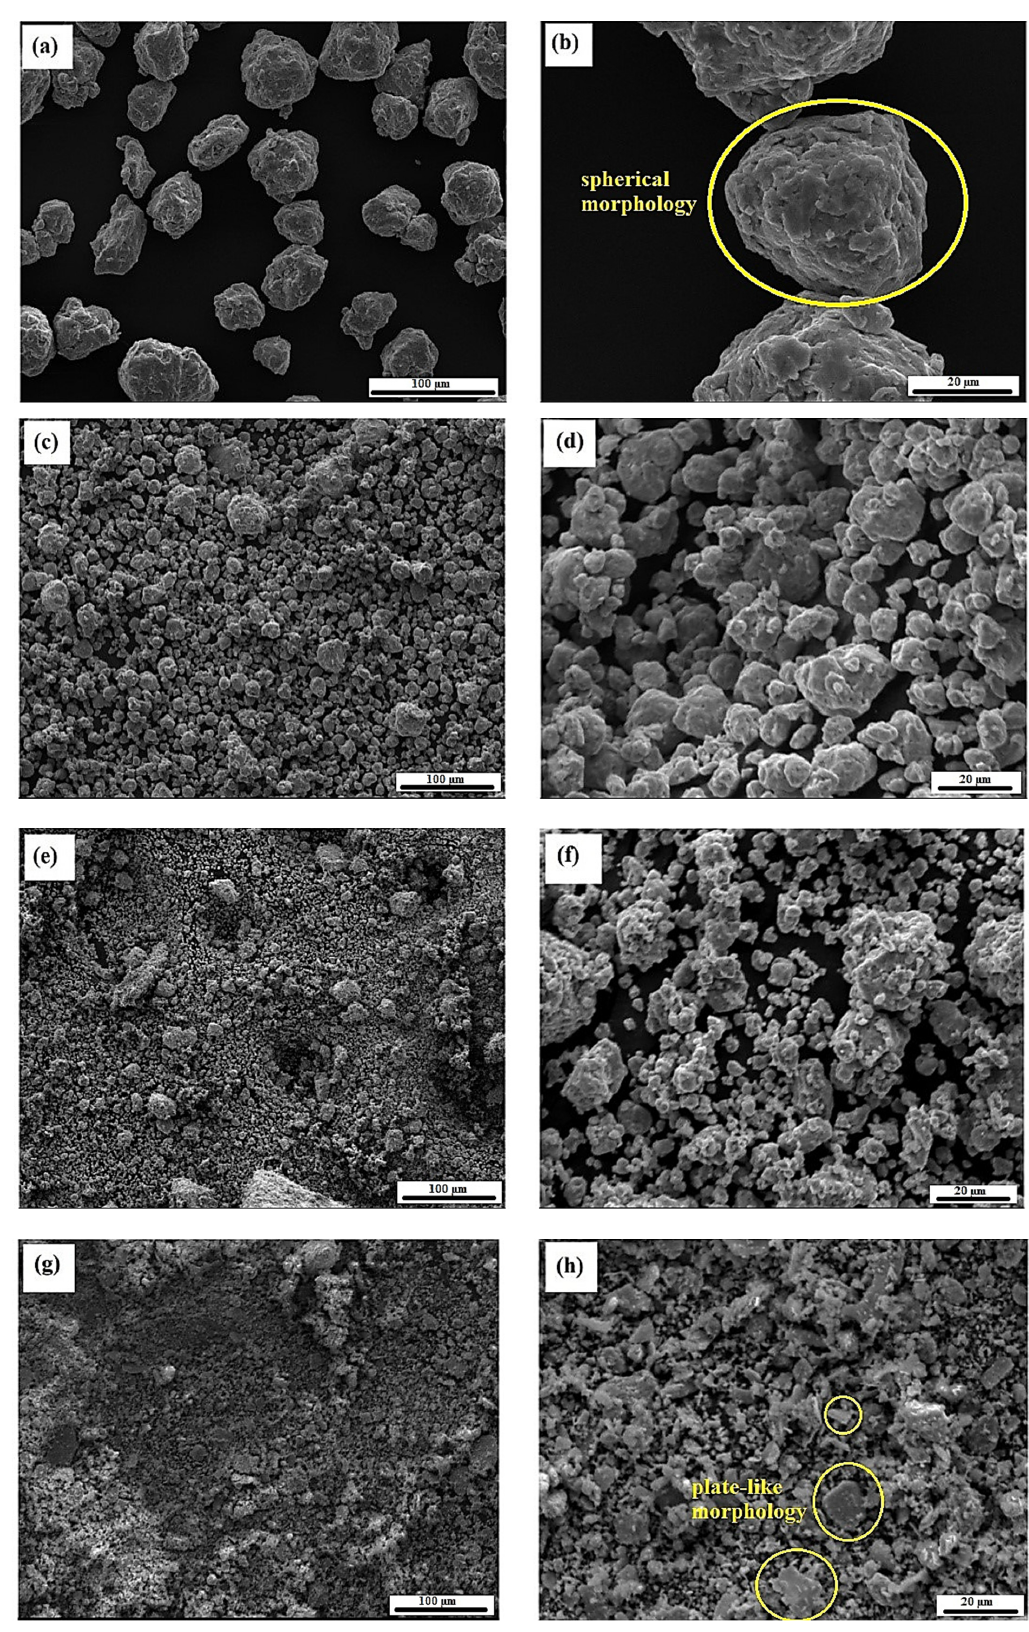
Figure 3. SEM images of mechanically alloyed AlCrCuFeNi HEA after 60 h of milling in the presence of ( a , b ) 1, ( c , d ) 2, ( e , f ) 3, and ( g , h ) 4 wt. % of PCA amount.